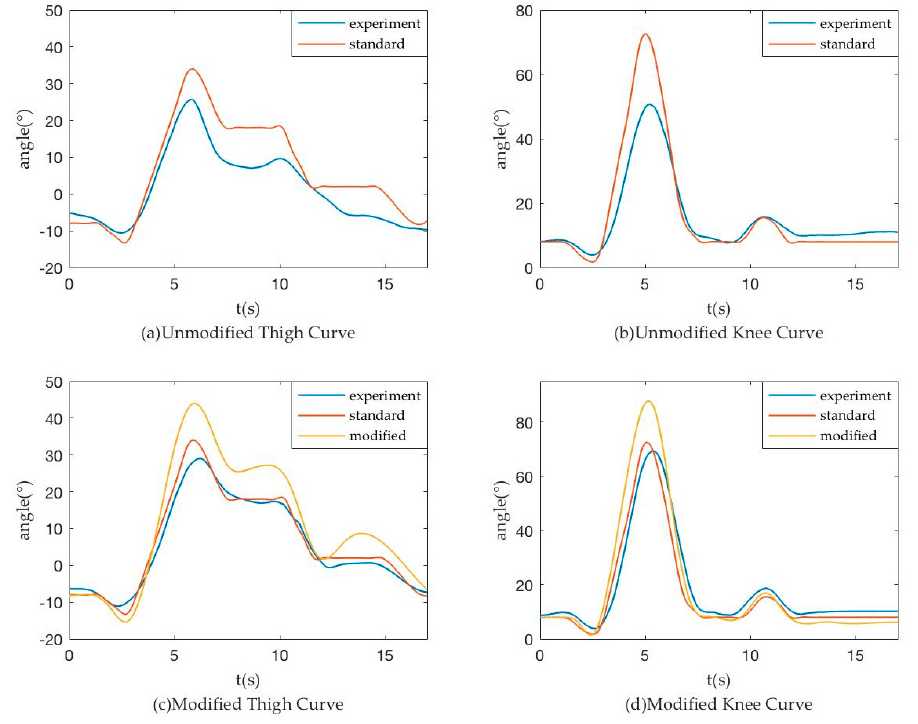
Figure 15. Modified Results.